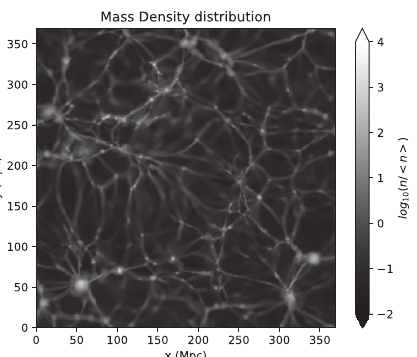
Figure 2. EGMF strength in nG for the primordial configuration in super-galactic coordinates at z = 0. Same coordinate system as Figure